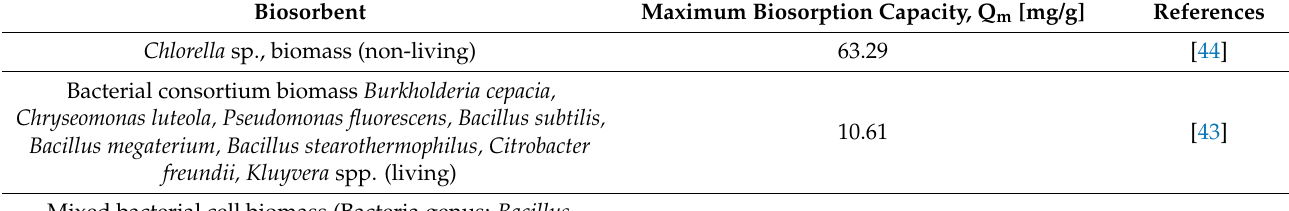
Table 3. Biosorption capacities of various biosorbents investigated for the removal of CPX from aqueous solutions.